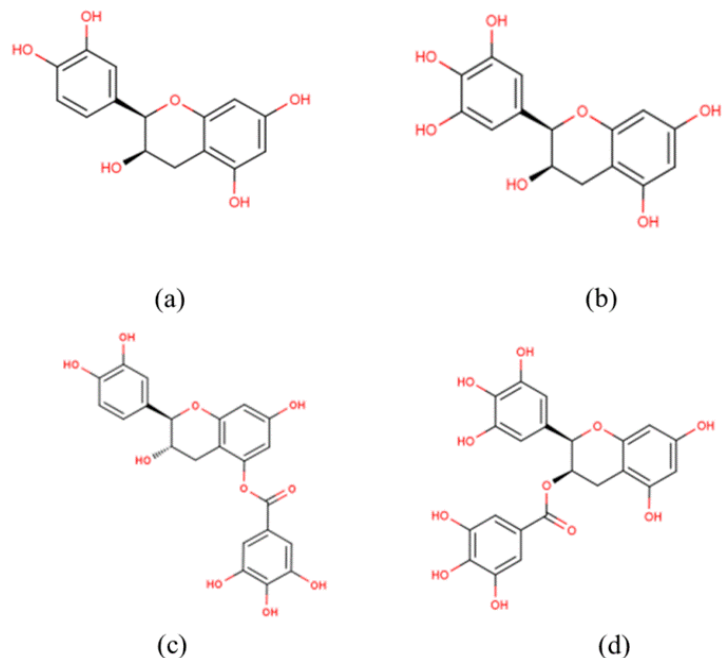
Figure 1. Chemical structures of green tea catechins: ( a ) Epicatechin (EC); ( b ) Epigallocatechin (EGC); ( c ) Epicatechin ‐ 3 ‐ gallate (ECG); ( d ) Epigallocatechin ‐ 3 ‐ gallate (EGCG) [26].